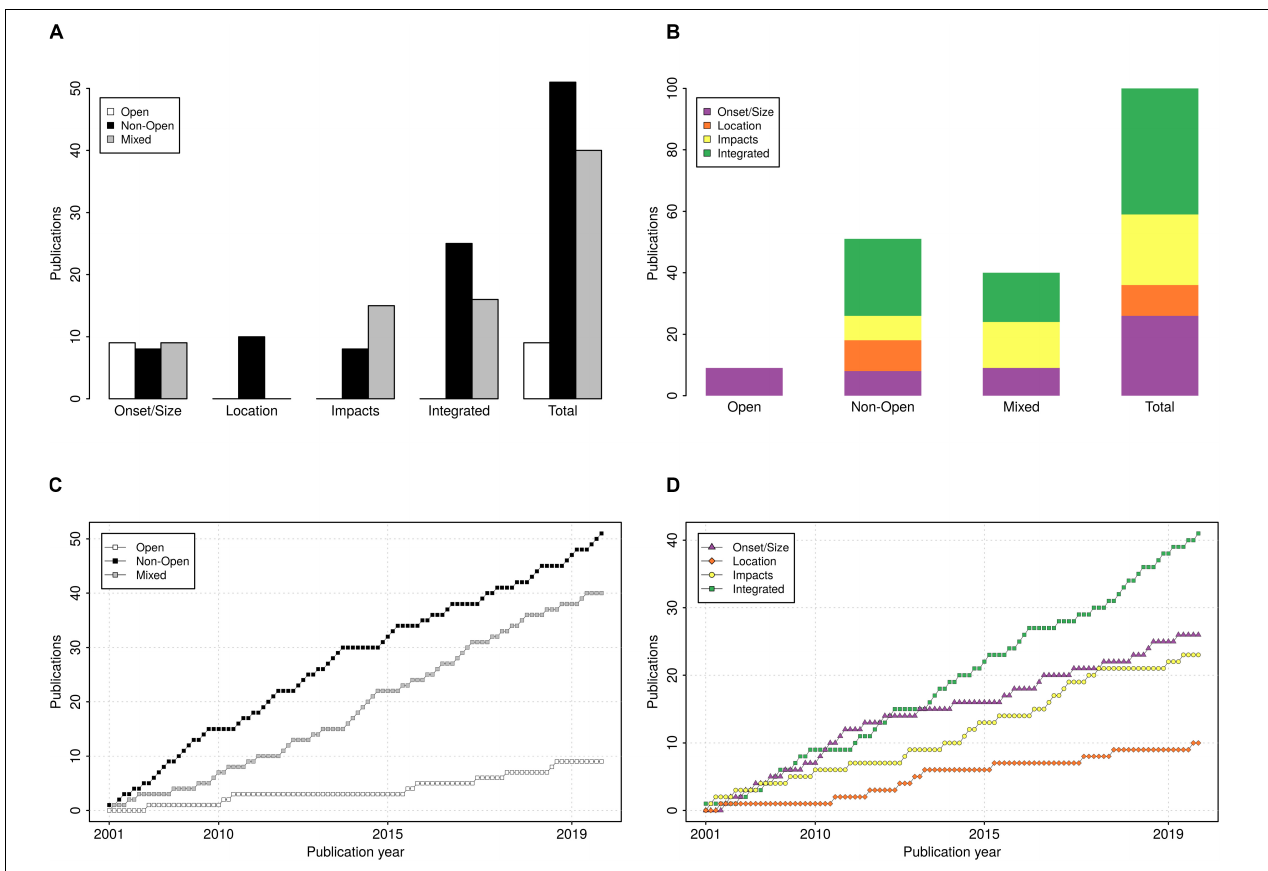
FIGURE 2 | Summary of patterns observed on a collection of 100 publications on long-term PVHA published since 2001. In (A,B) : total number of publications partitioned according to the use of open, non-open and mixed datasets (A) ; and the focus of the PVHA: eruption onset and/or size, eruption location, eruption impacts or integrated PVHA (B) . In (C,D) : cumulative number of publications according to the same partitions: type of data (C) and focus of the PVHA (D) . Publications are sorted, in ascending order, by the year of publication and, for those with the same publication year, by alphabetical order. The x axis displays the resulting ordinal numbering ( ID variable in the Supplementary Material ). Labels on the x axis are placed on the first publication of the corresponding publication